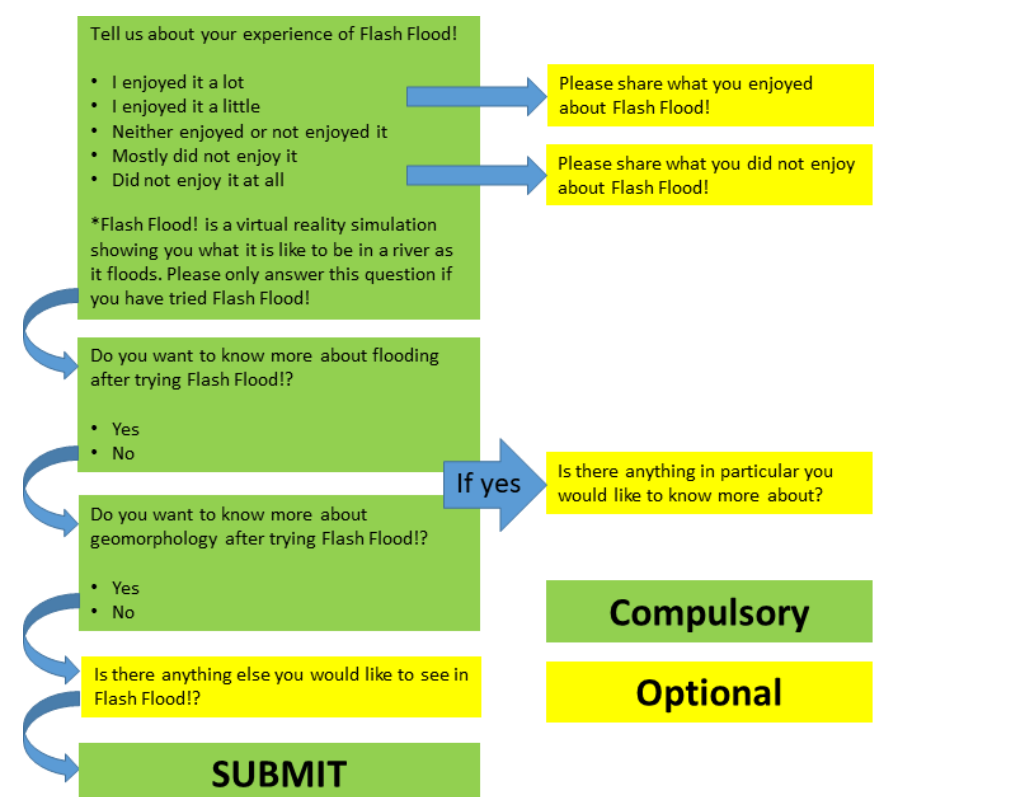
Figure 5. Flow diagram showing the questionnaire design. All respondents are offered all questions on the left-hand side, whilst questions on the right-hand side were only shown under indicated conditions. All questions in green boxes had to be answered to allow the form to submit.